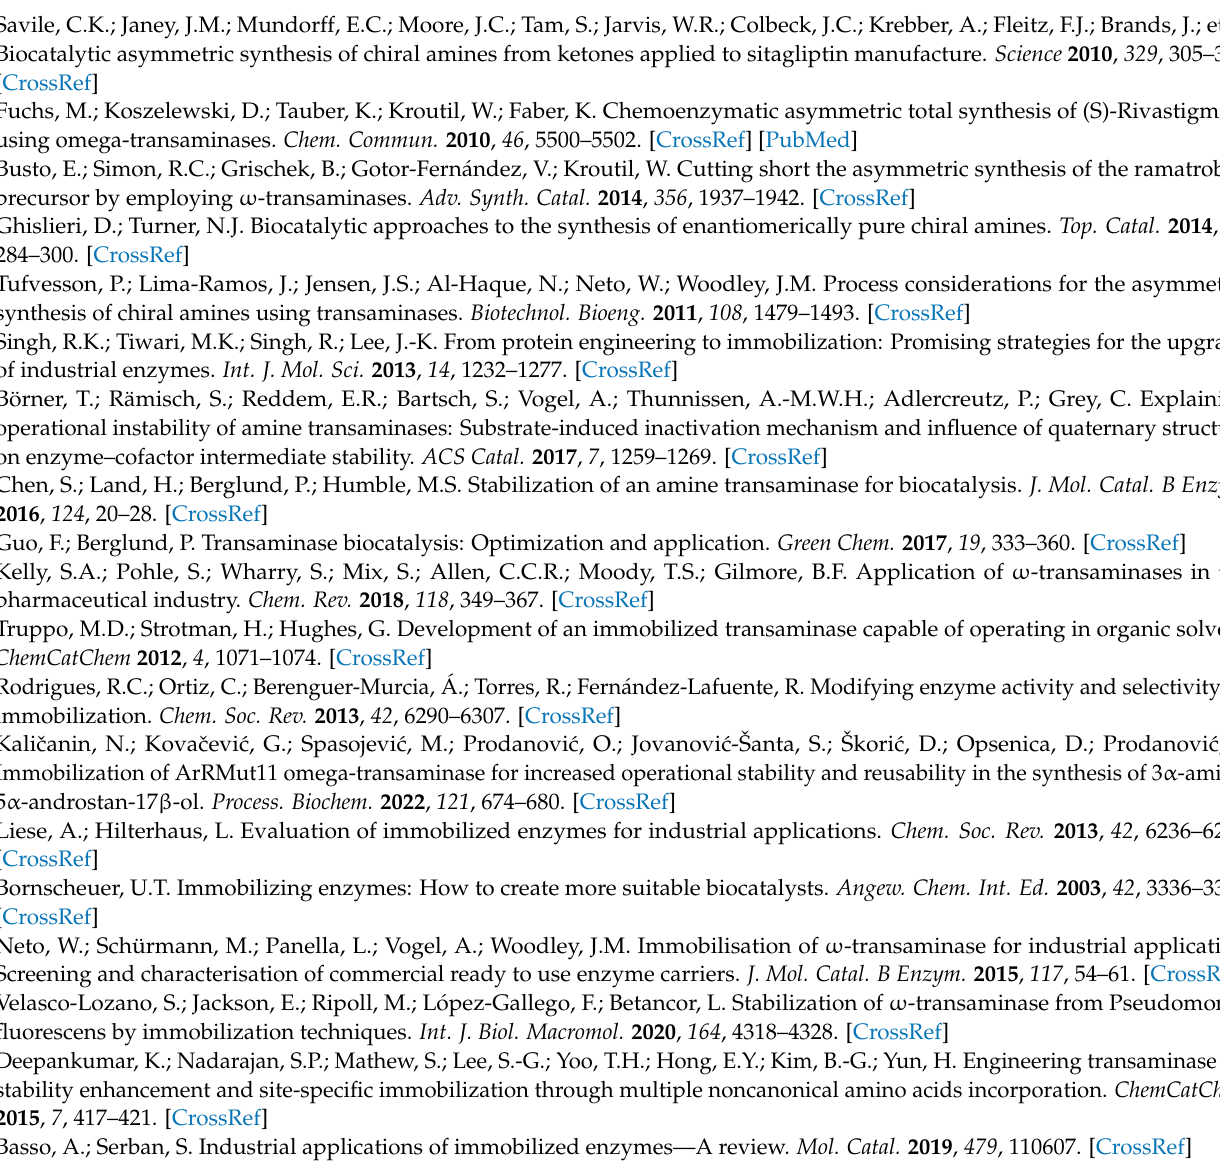
Section S8: fluorescent-labeling of FGly; Figure S9: fluorescent-labeling of formylglycine (exemplary for ATA-Vfl-AH); and Section S9: supporting